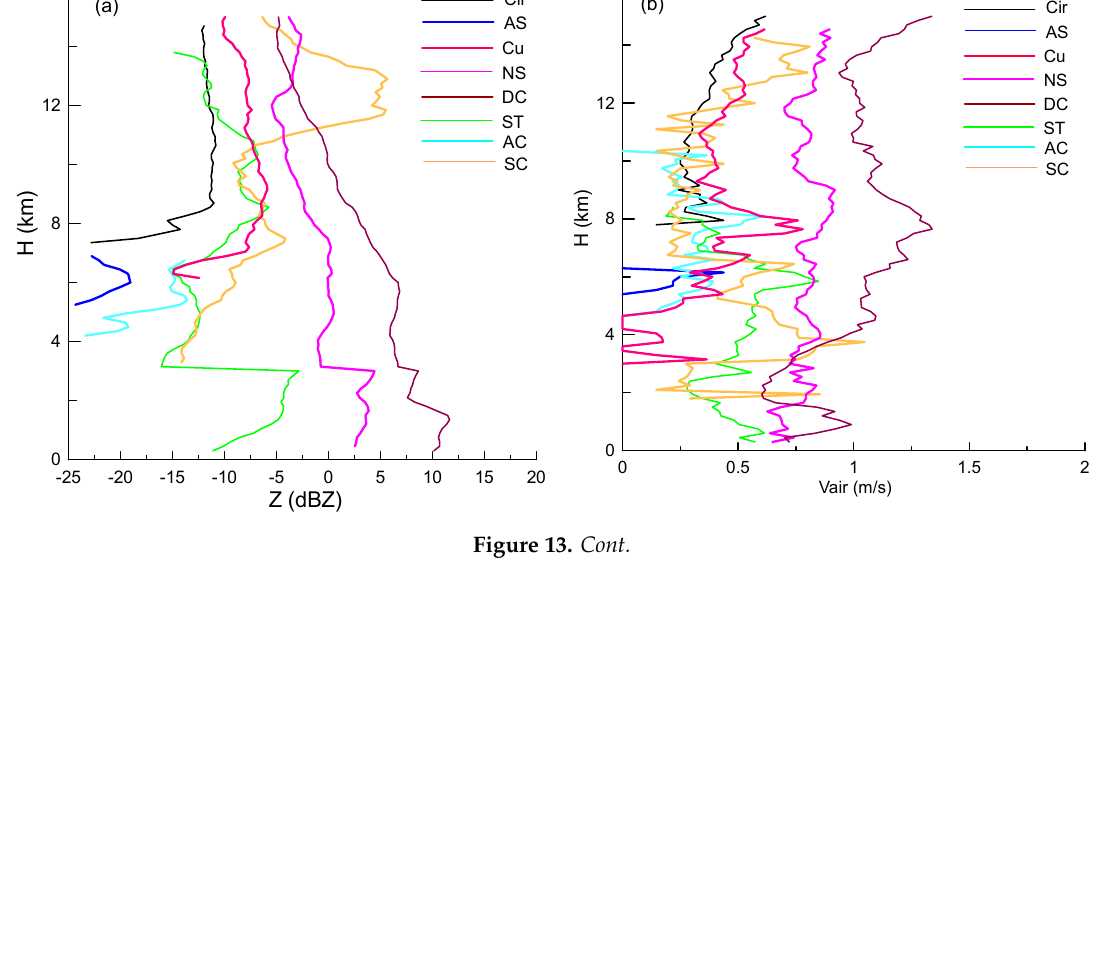
Figure 12. Diurnal variations of the cloud occurrence frequencies corresponding to eight cloud types: ( a ) Cir, Dc, Ac, and St, ( b ) Sc, Cu, Ns, and As.